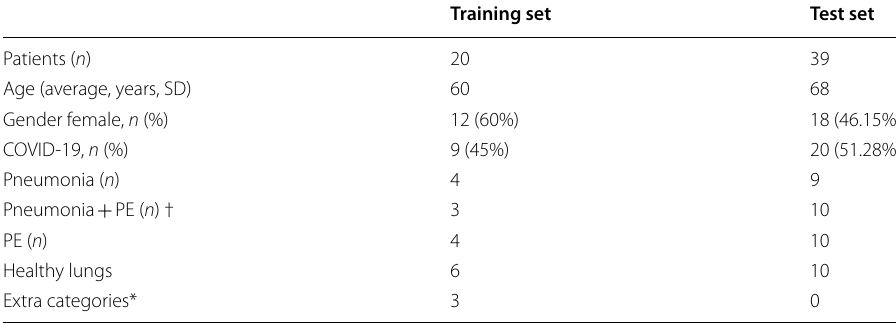
Table 1 Demographic